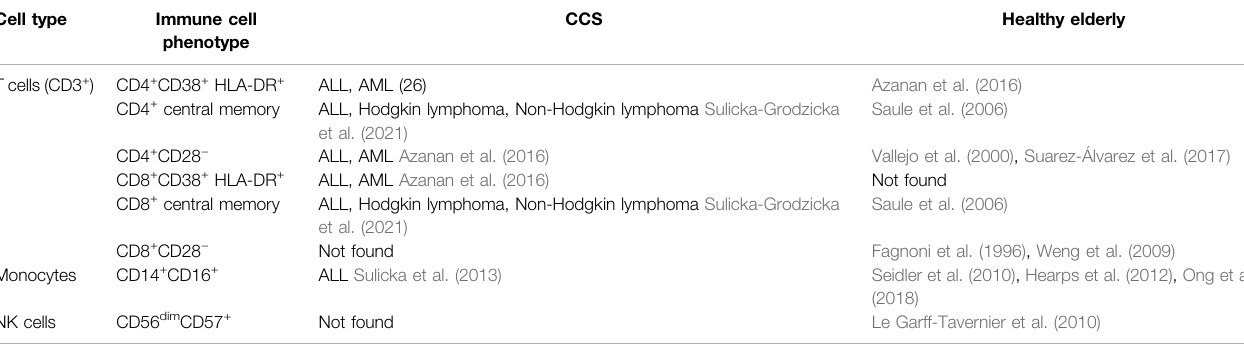
TABLE 2 | The phenotypes of cellular subsets associated with senescence/immunosenescence in CCS and the healthy elderly. Cell type